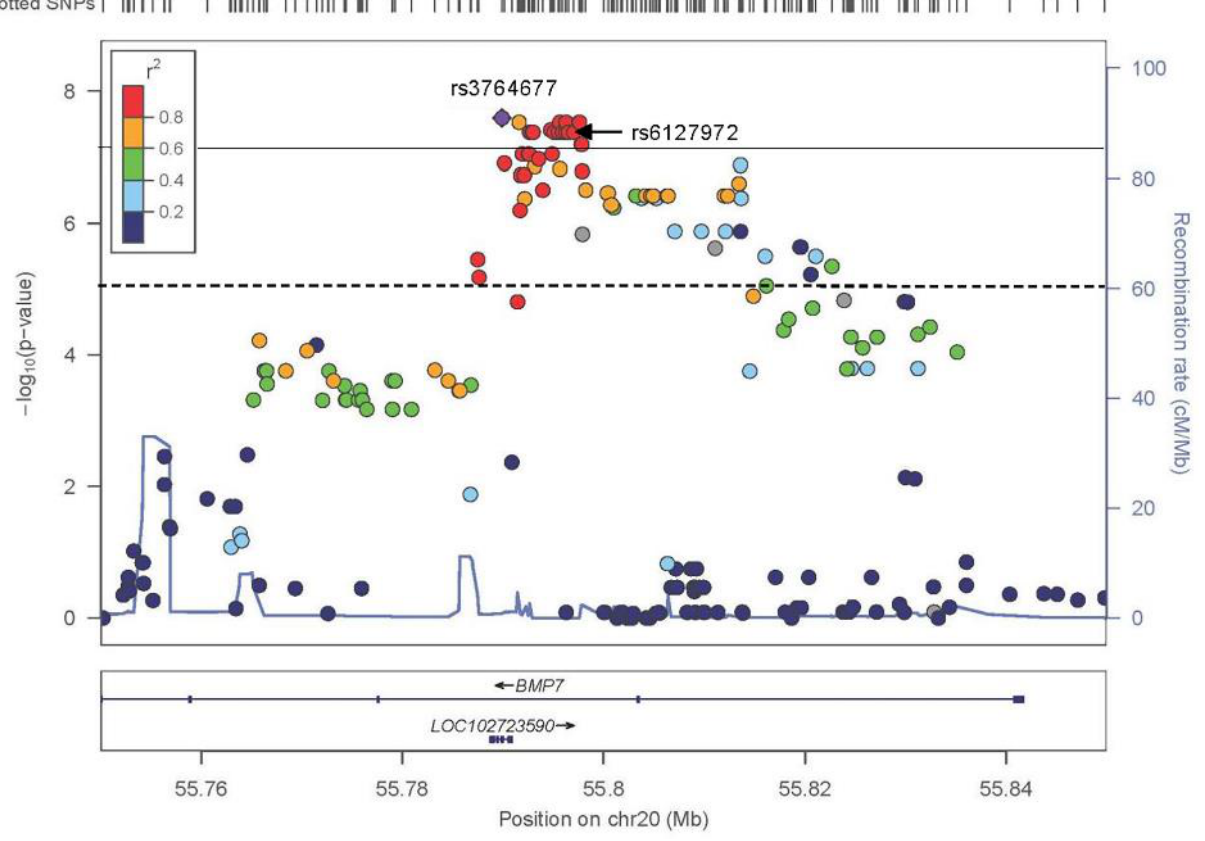
Figure 2. The results of the TDT for the metopic synostosis when all 80 trios are included in the anal- ysis. Here, the dotted line represents the genome-wide suggestive threshold of 1.00 × 10 − 5 , andthe straight line represents the genome-wide significant threshold of 5 × 10 − 8 . The LD ( r 2 ) between the top associated SNV rs3764677 ( p = 2.55 × 10 − 8 ) and other SNVs are indicated. The location of rs6127972, the most significantly associated SNV from the mNCS GWAS, is indicated with an arrow. GWAS, genome-wide association study; LD, linkage disequilibrium; mNCS, metopic nonsyndromic craniosynostosis; SNV, single nucleotide variant; TDT, transmission disequilibrium